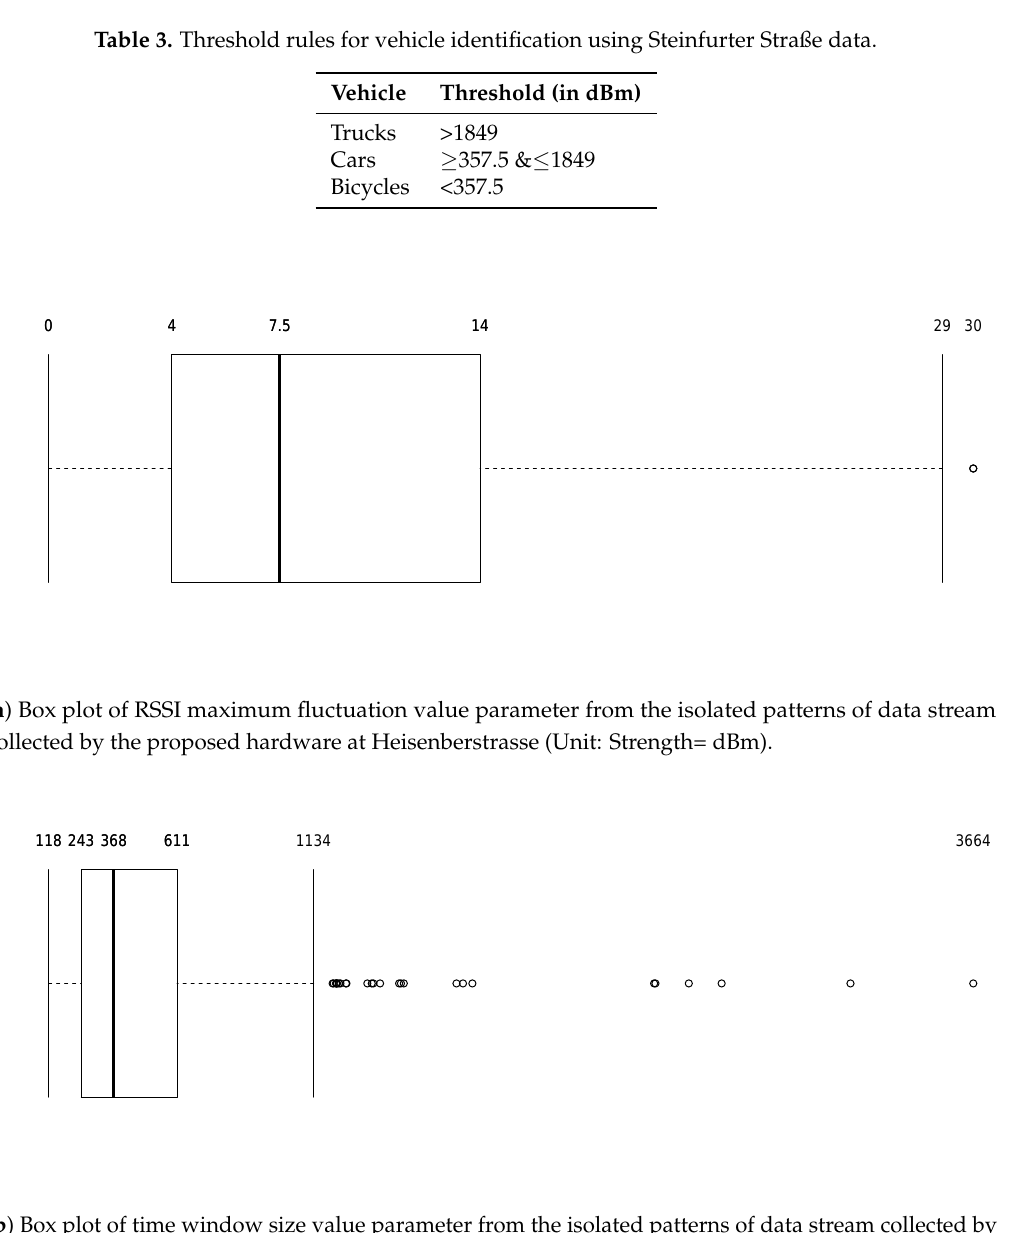
Figure 8. Parameters summary statistics for